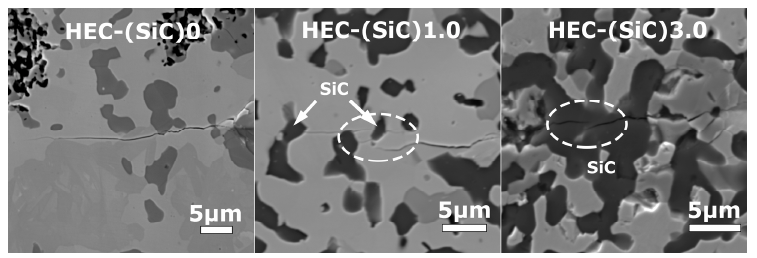
Figure 2. SEM micrographs of indentation cracks in HEC-(SiC)x composite sintered at 2000 °C, under the indentation load of 1000 g.